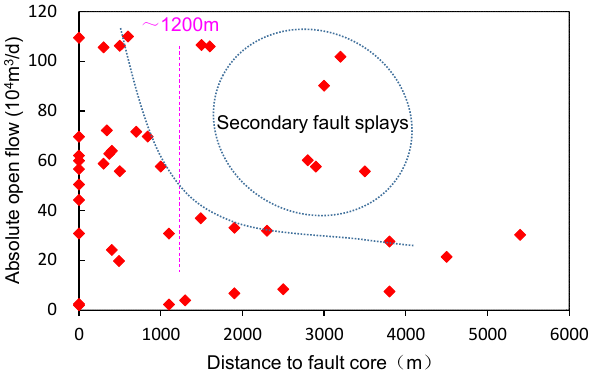
Figure 8. The absolute open flow of a gas well vs. distance to fault core at the fourth member of the Denying Formation in Anyue Gasfield.